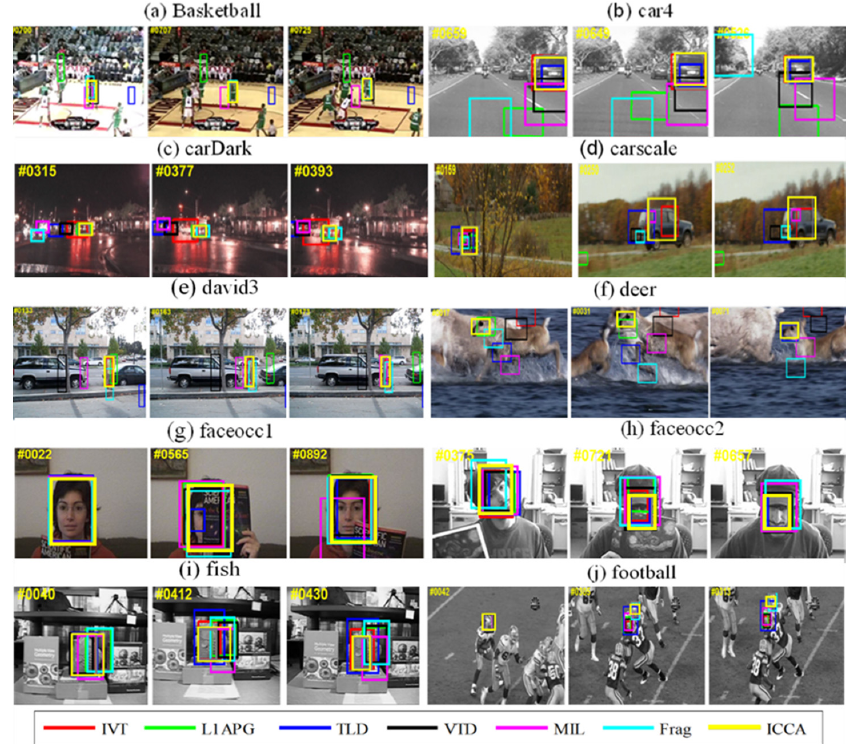
Figure 1. Tracking results of several trackers on ten videos. The bounding boxes of several trackers on three representative frames of ( a ) Basketball, ( b ) car4, ( c ) carDark, ( d ) carscale, ( e ) david3, ( f ) deer, ( g ) faceocc1, ( h ) faceocc2, ( i ) fish, and ( j ) football, respectively.